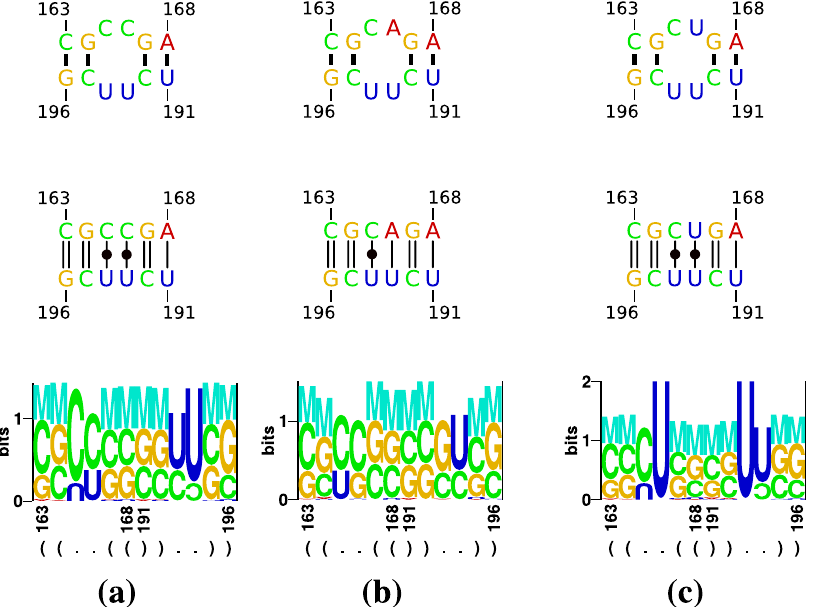
Figure 3. Results of Rosetta modelling of IL1 variants. Results of Rosetta modelling are shown for three typical loop variants: CC/UU ( a ), CA/UU ( b ), and CU/UU ( c ). Top: secondary structure of IL1 used as input to Rosetta modelling; that is, the input structure was ((..(( + ))..)) for all three sequences. Middle: interactions identified by rnaview in Rosetta’s top model; standard cWW base pairs are marked by double lines; all “loop” nucleotides are paired in cWW conformation; for the basepairing nomenclature of Leontis & Westhof 77 see Supplementary Fig. S1. Bottom: Logos produced by RNAredesign for Rosetta’s top model.